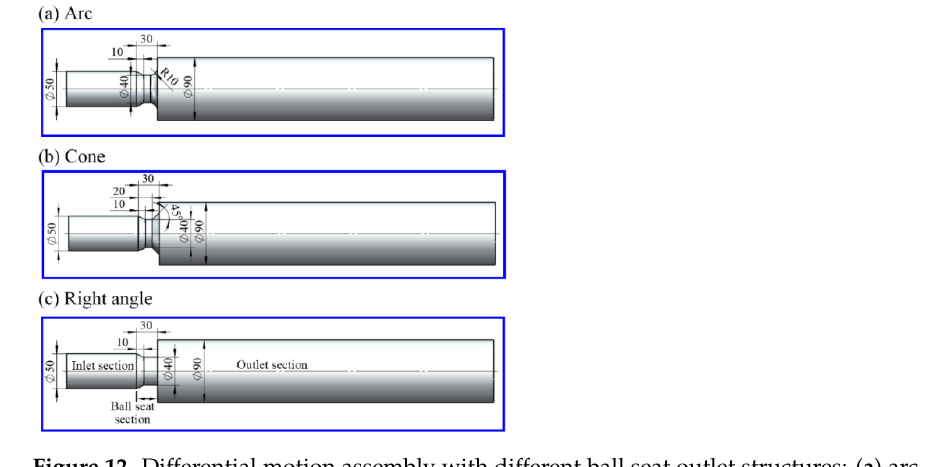
Figure 12. Differential motion assembly with different ball seat outlet structures: ( a ) arc, ( b ) cone, and ( c ) right angle.